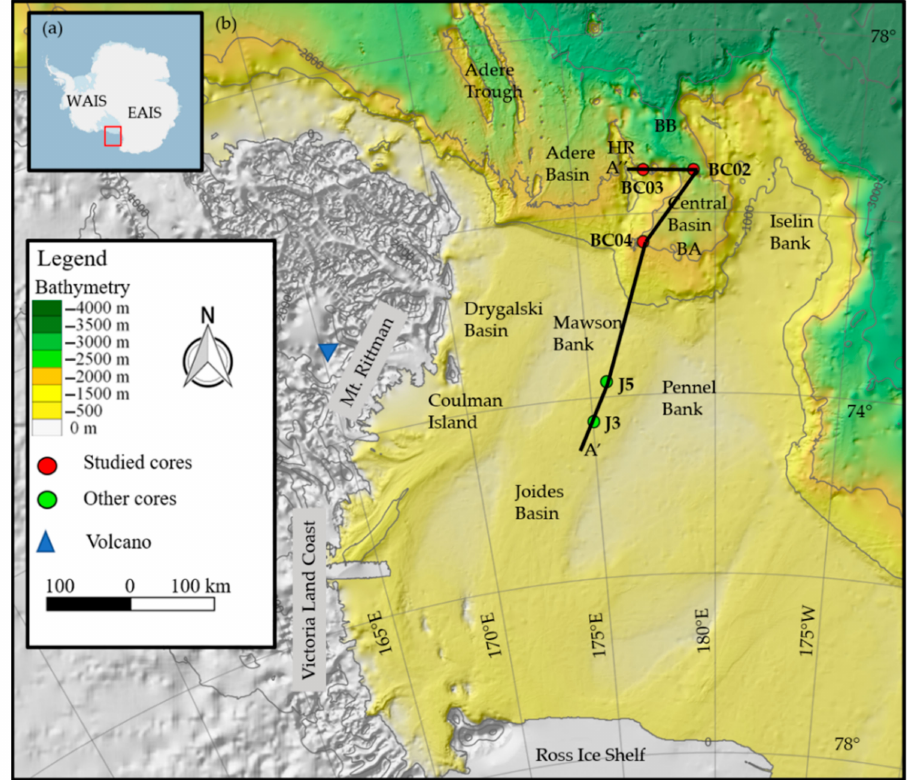
Figure 1. Bathymetric map of the Ross Sea (modified from [24]). WAIS = West Antarctic Ice Sheet, EAIS = Eastern Antarctic Ice Sheet. The red rectangle indicates the studied area. HR = Hallett Ridge, BA = Bank A, BB = Bank B. Red dots indicate the studied box cores: BC02 = KI13 − BC02; BC03 = KI13 − BC03; BC04 = KI13 − BC04. Green dots indicate cores J5 (ANTA99 − cJ5) and J3 (ANTA99 − cJ3) studied by [25]. The black line is the axis for the schematic model presented in Section